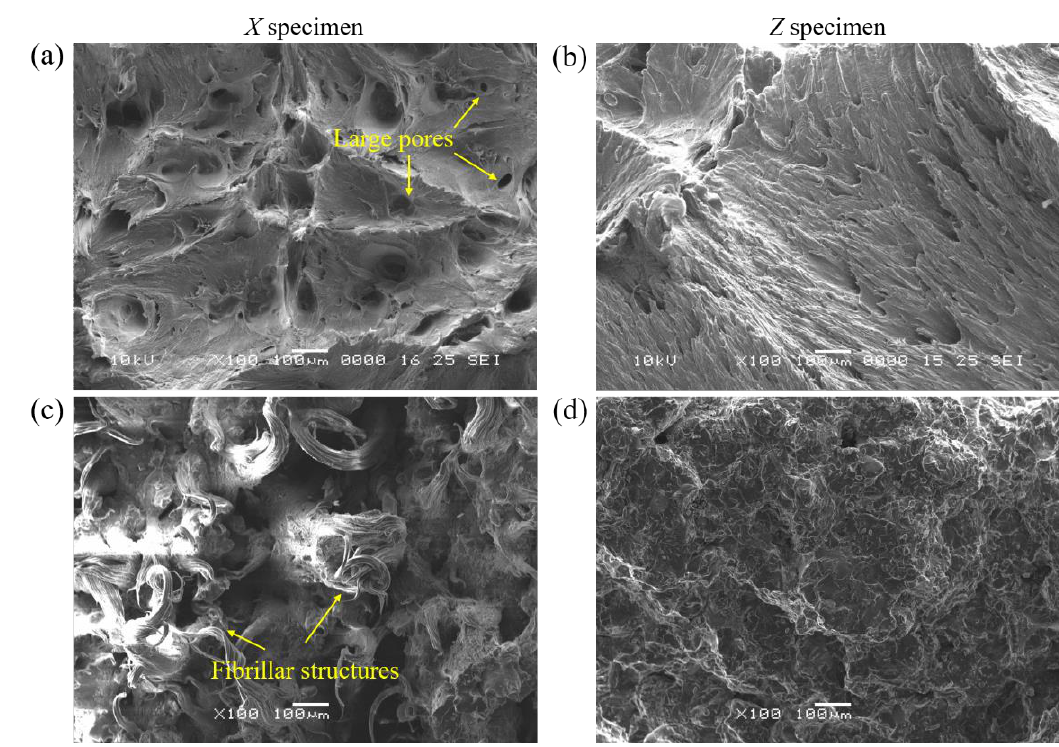
Figure 9. Fracture morphologies of specimens: ( a , b ) PA11 and ( c , d ) TPU. Table 5. Tensile properties of the PA11 and TPU specimens.